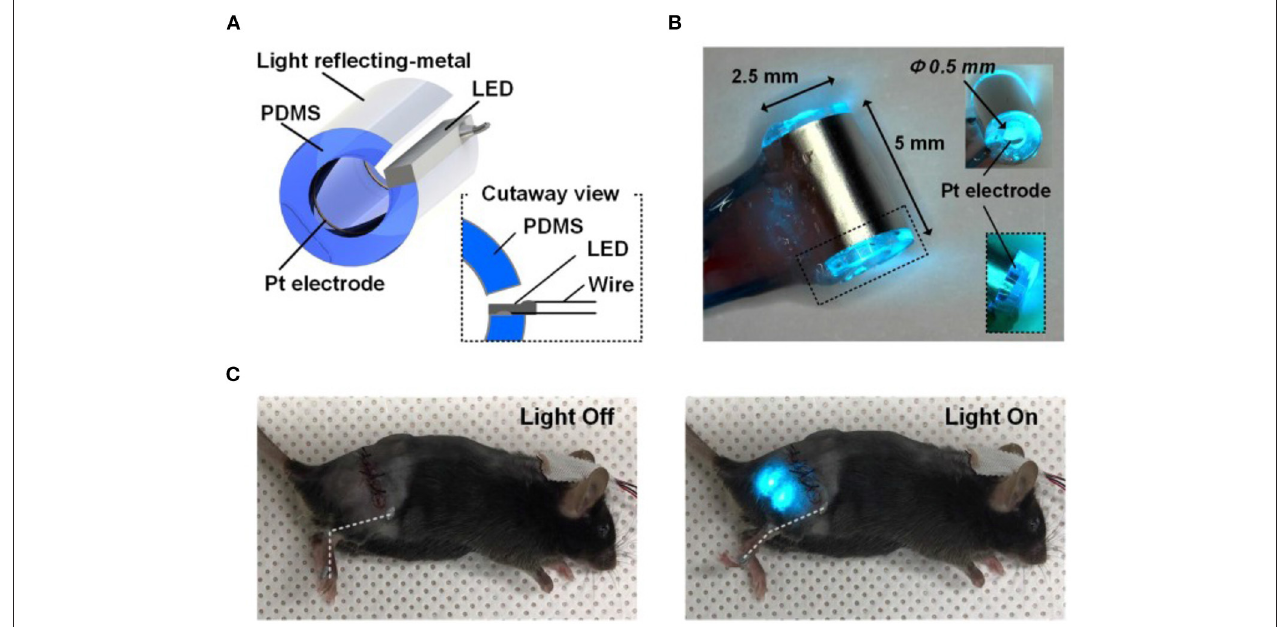
FIGURE 13 | Optical nerve-cuff electrode for optogenetic stimulation of peripheral neurons in freely moving animals. (A) Overall schematic illustration of the optical nerve cuff electrode. (B) Picture of an active photo-stimulating device. (C) Pictures of a mouse implanted with the opto-cuff electrode in (A,B) . Examples of light off and light on states are shown. Modified with permission from Song et al.